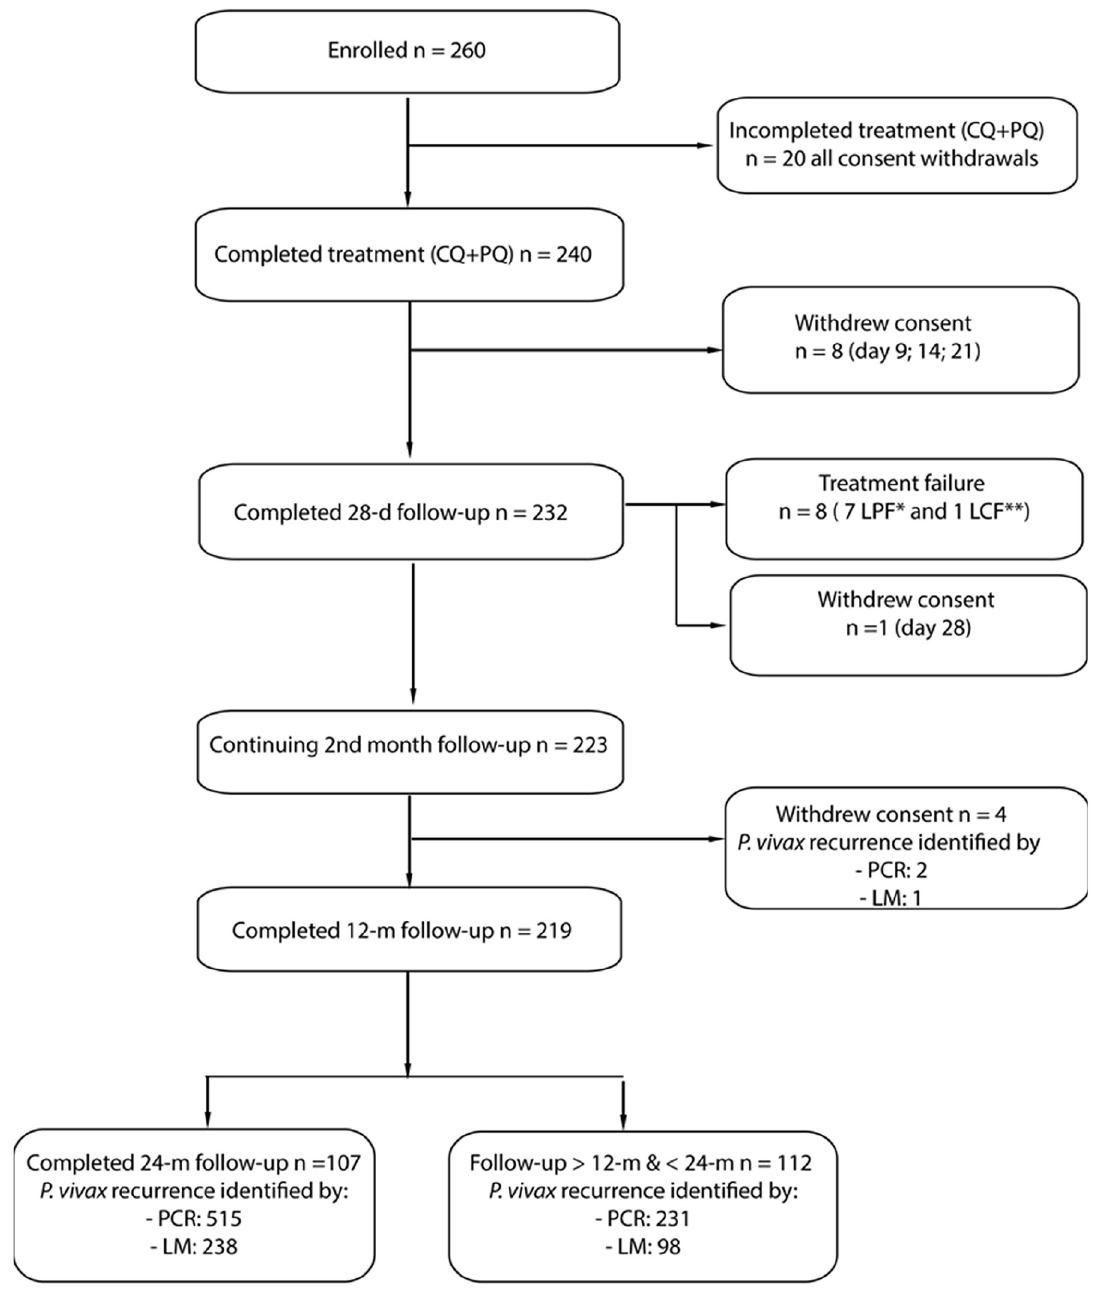
Fig 1. Study profile. CQ, chloroquine; d, day; LCF, Late Clinical Failure; LM, light microscopy; LPF, Late Parasitological Failure; m, month; PCR, polymerase chain reaction; PQ,